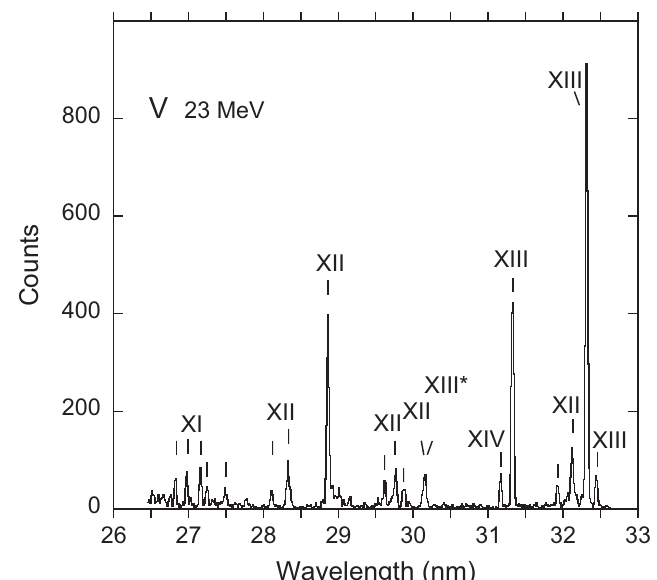
Figure 4. Beam-foil spectrum of 51 V recorded at an ion beam energy of 20MeV, near the optimum ion beam energy for the production of the VXIII spectrum [74]: Line width (FWHM) is 0.035 nm. The more prominent ones among the lines are labeled by the spectrum number [75]. Near 31.3 nm and 32.3 nm lie the prominent and well-known 3p–3d transitions of singly excited VXIII. The VXIII* line of present interest at λ ≈ 30.2 nm appears slightly broader than the other lines. The blend with a VXII line enlarges the uncertainty of the wavelength determination.